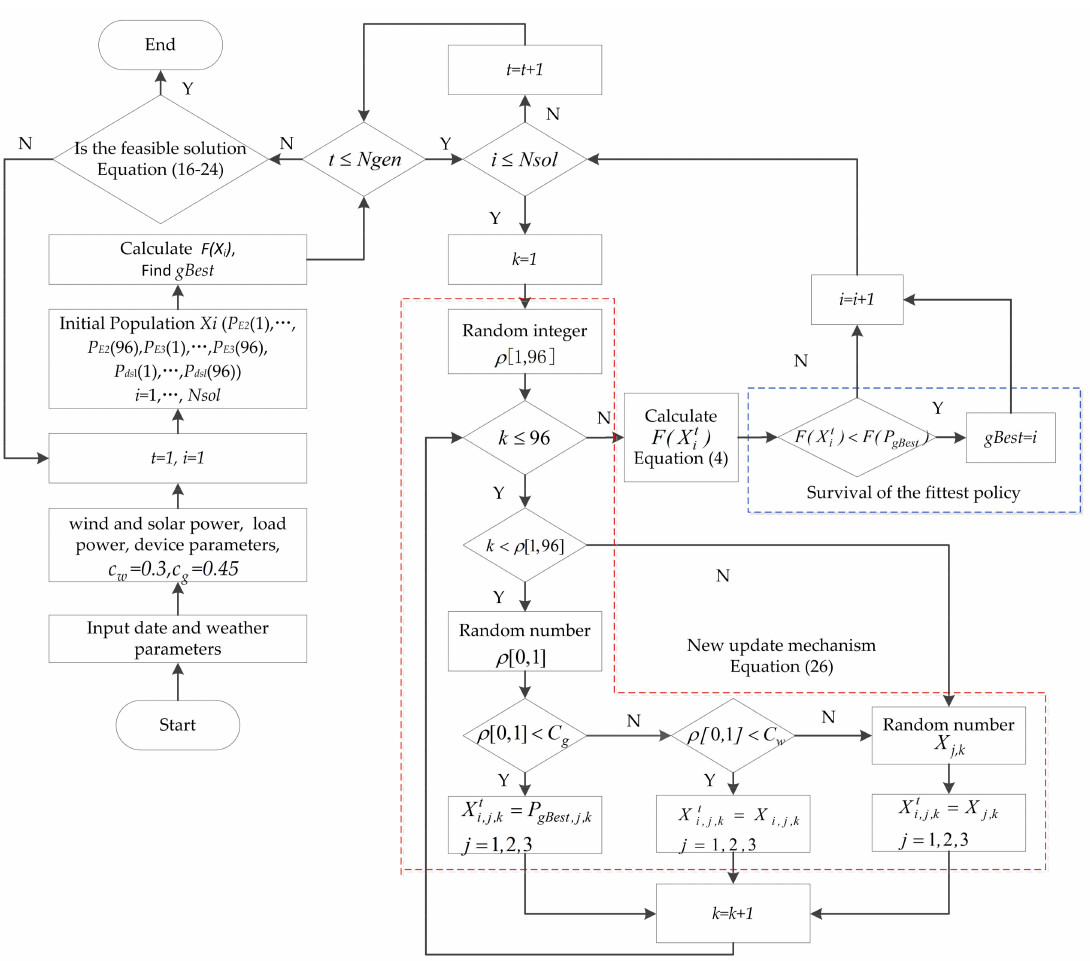
Figure 7. Flowchart of economic dispatch of modular microgrid based on the iSSO method.